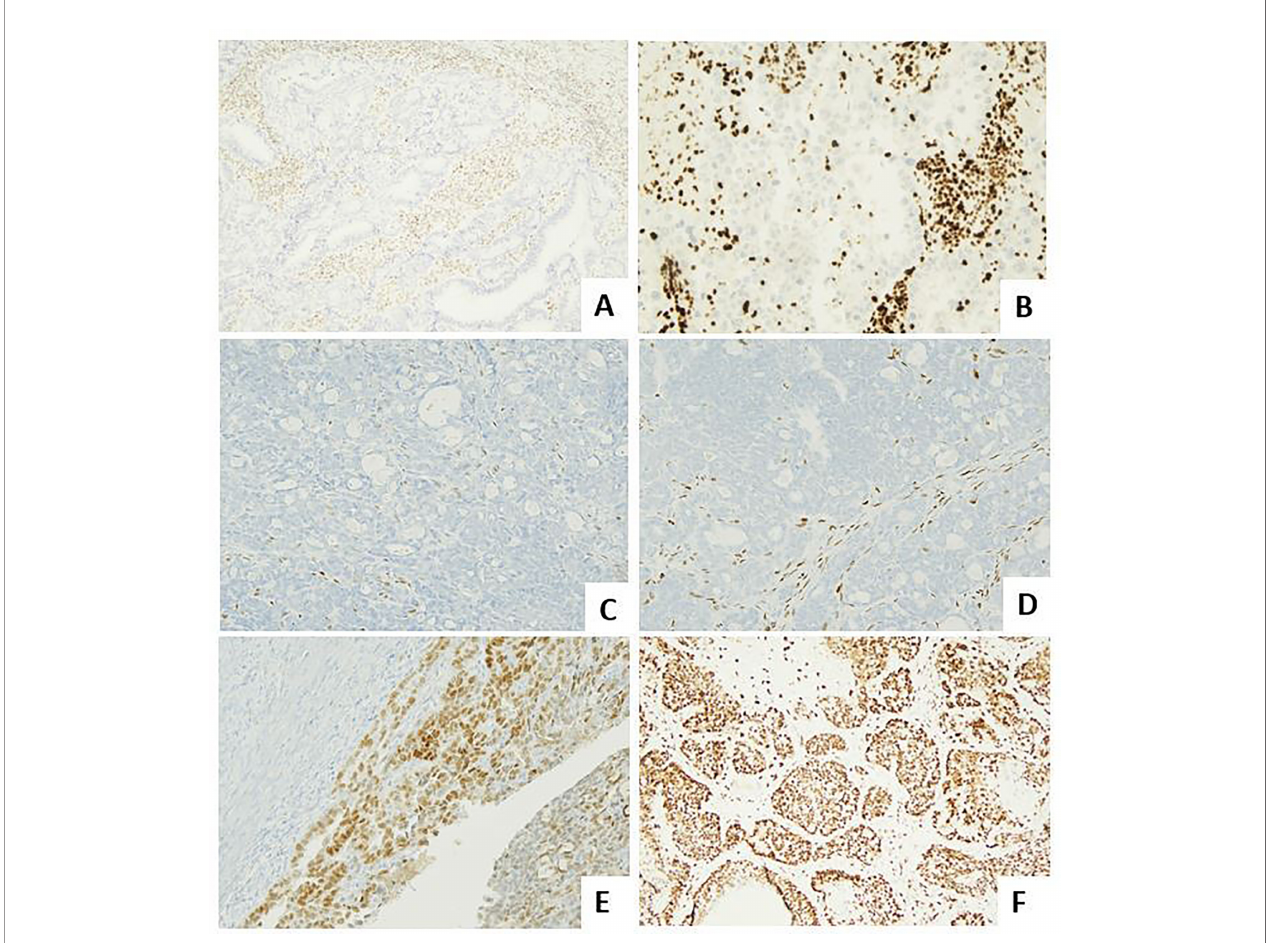
FIGURE 2 | Molecular landscape of endometrial carcinoma: the role of the immunohistochemical surrogates. (A) An endometrioid carcinoma G2 FIGO with loss of MLH1 expression (LSAB, 10×). (B) An endometrioid carcinoma G2 FIGO with loss of MSH2 expression (LSAB, 10×). (C, D) An endometrioid carcinoma G3 FIGO with loss of ER (LSAB, 10×) and PR (LSAB, 10×). (E) An endometrioid carcinoma G2 FIGO with expression of ER in 80% of neoplastic cells, with a 2+ score intensity (LSAB, 10×). (F) A serous carcinoma with overexpressed aberrant pattern of p53 (LSAB,